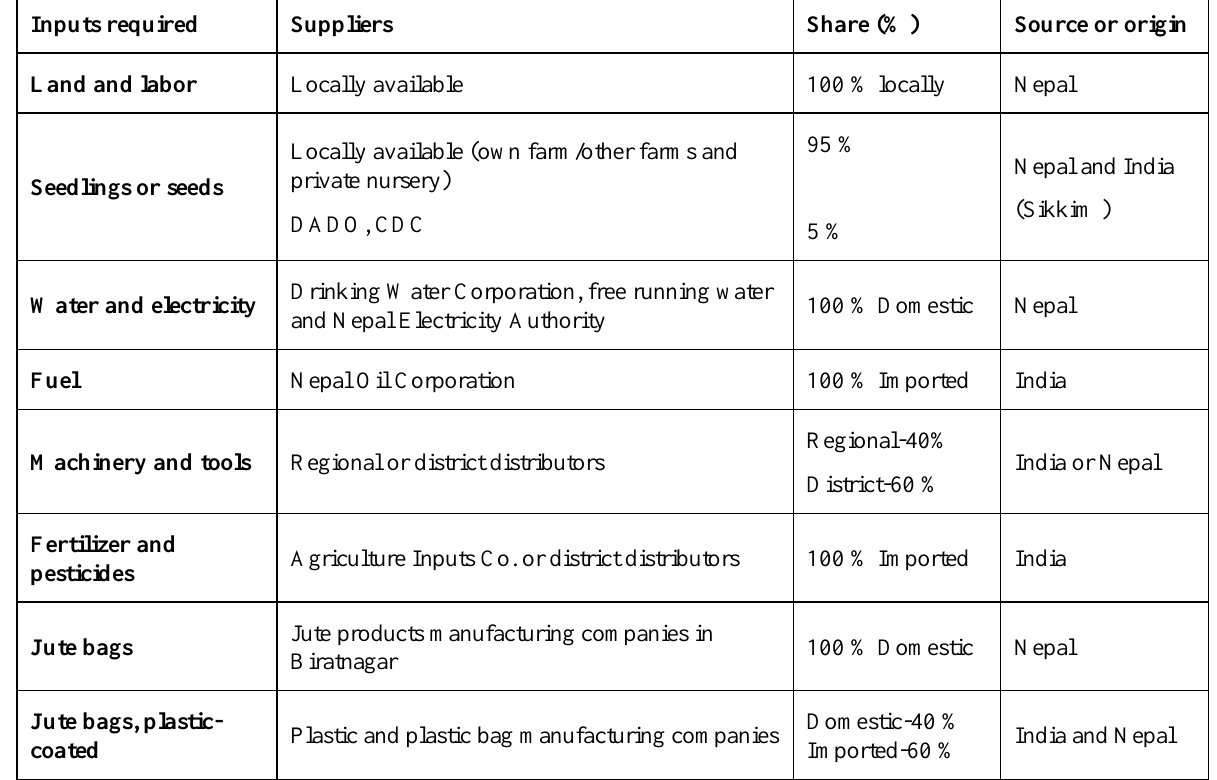
Table 4. Input requirements and suppliers’